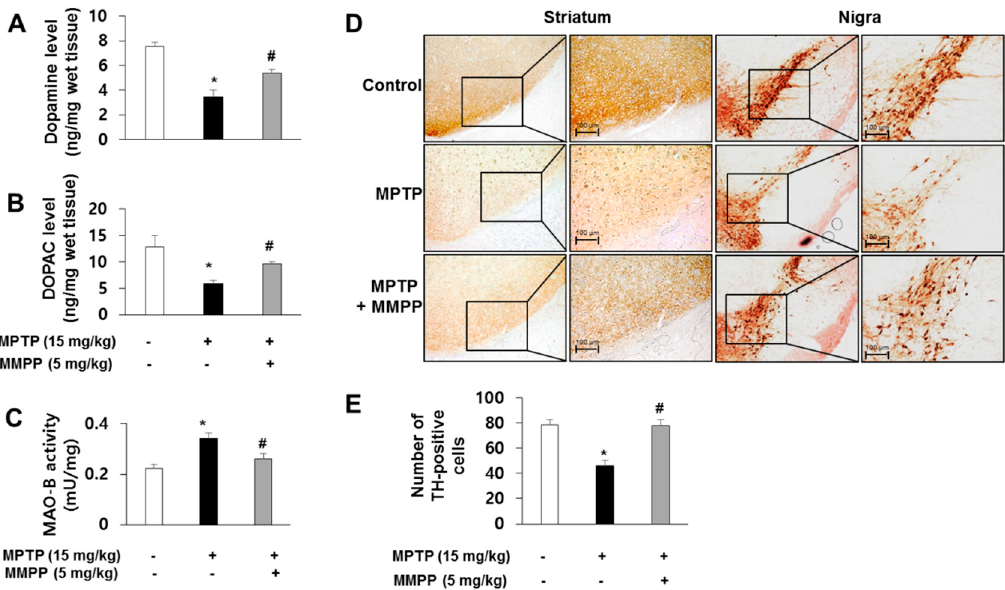
Figure 3. MMPP ameliorates MPTP-induced dopaminergic neurodegeneration. The levels of dopamine (A) and 3,4-Dihydroxyphenylacetic acid (DOPAC) (B) in mouse brains were determined by HPLC. Monoamine oxidase B (MAO-B) activity was determined with an assay kit (C). The effect of MMPP on tyrosine hydroxylase (TH)-positive neurons was measured by immunohistochemistry (D and E). Representative stained tissues were viewed with a microscope (50× or 200× magnification). Values are presented as mean ± SD from 10 mice. * p < 0.05, significant difference from saline-injected mice; # p < 0.05, significant difference between MPTP-injected groups.